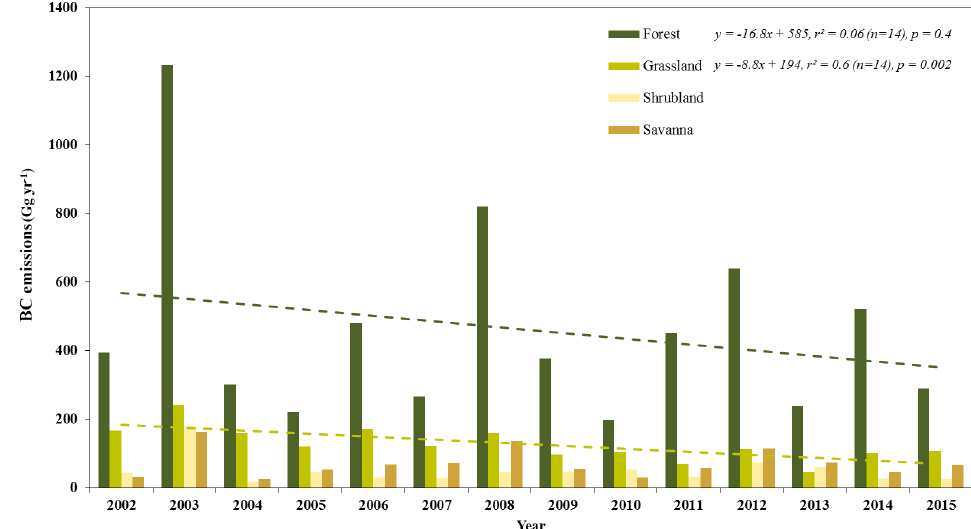
Figure 6. Interannual variability of BC emissions for different land cover types in northern Eurasia from 2002 to